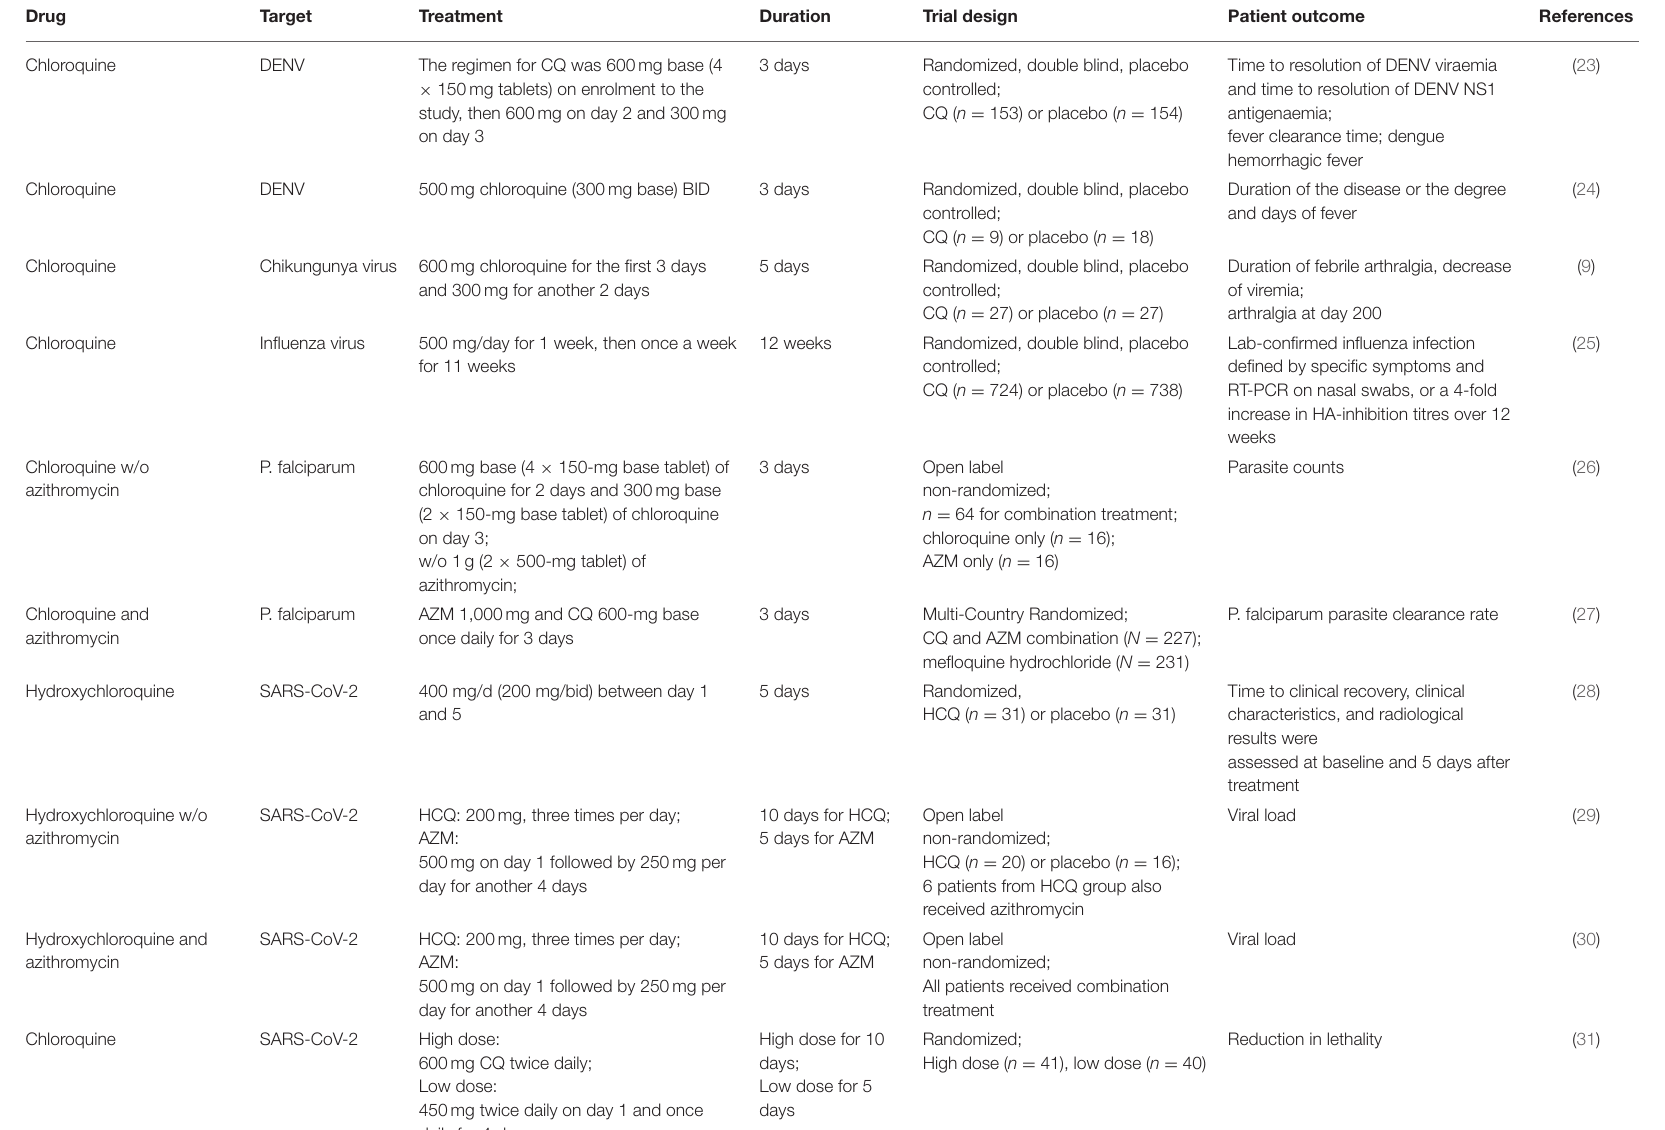
TABLE 1 | Clinical trials of hydroxychloroquine or chloroquine w/o azithromycin in patients with infectious disease.